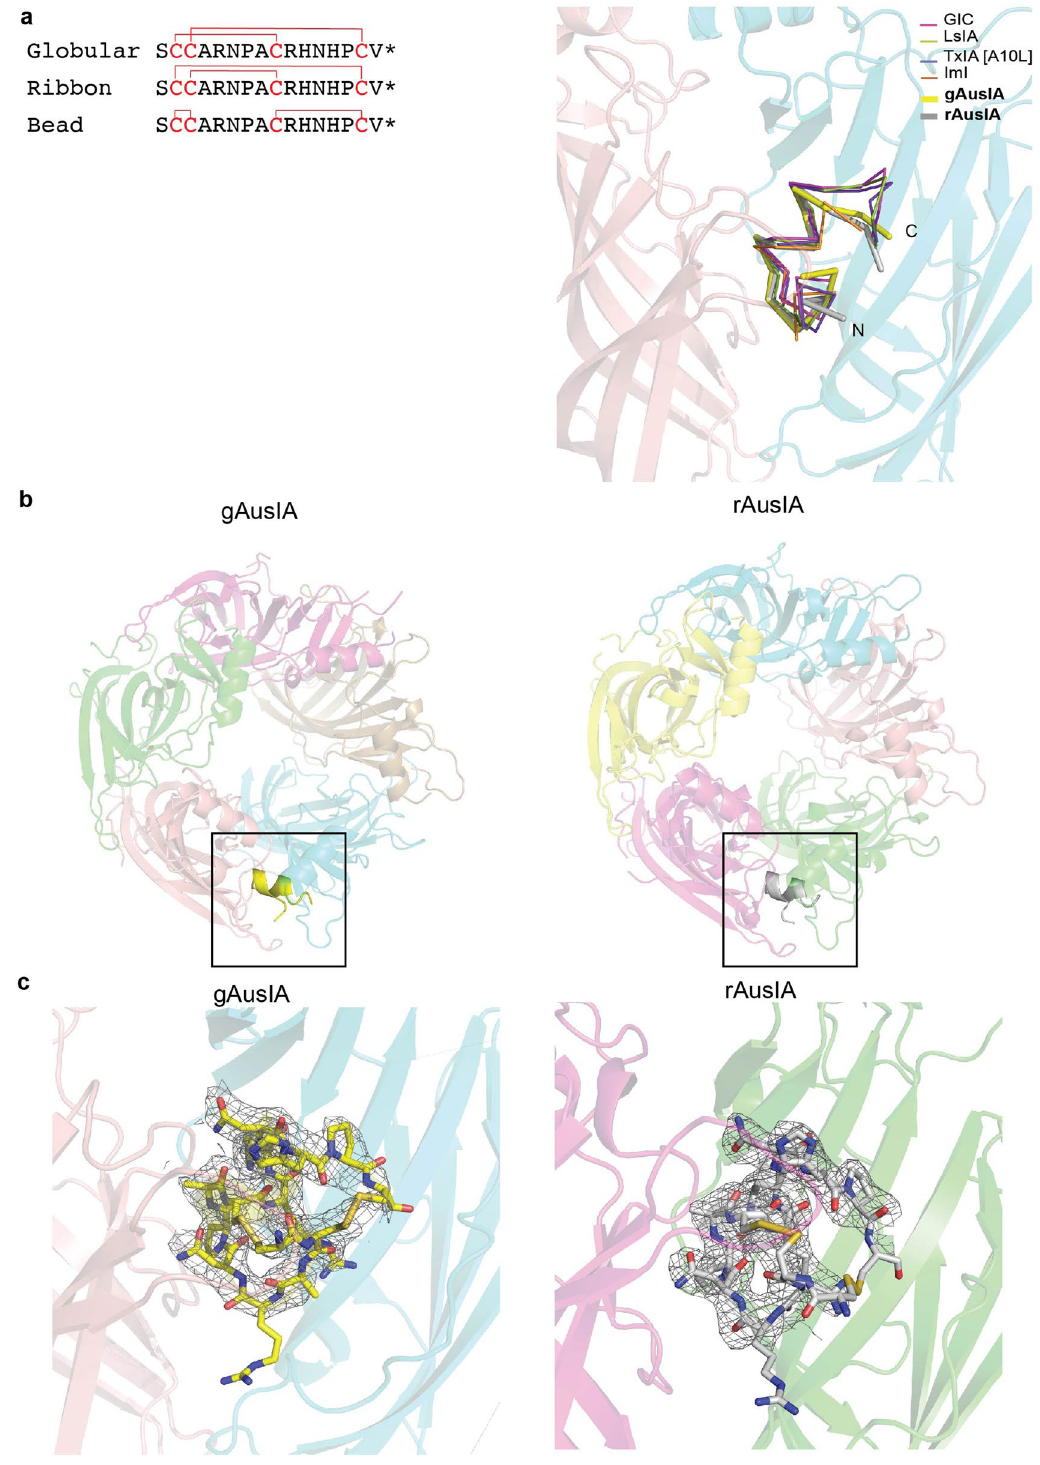
Figure 1. The gAusIA/ Ls -AChBP and rAusIA/ Ls -AChBP co-crystal structures. ( a ) The superimposition of gAusIA and rAusIA with previously co-crystallised α-conotoxins shows the similar backbone orientation. ( b ) Clear electron density for gAusIA and rAusIA is seen in only one binding pocket. ( c ) Fo-Fc maps for the ligand contoured to 1.0 s are shown. The typical binding mode of α-conotoxin is presented by both gAusIA and rAusIA in which the N and C termini of the bound α-conotoxin orienting towards the top and bottom of the ligand binding pocket respectively and the central helix abutting into the binding